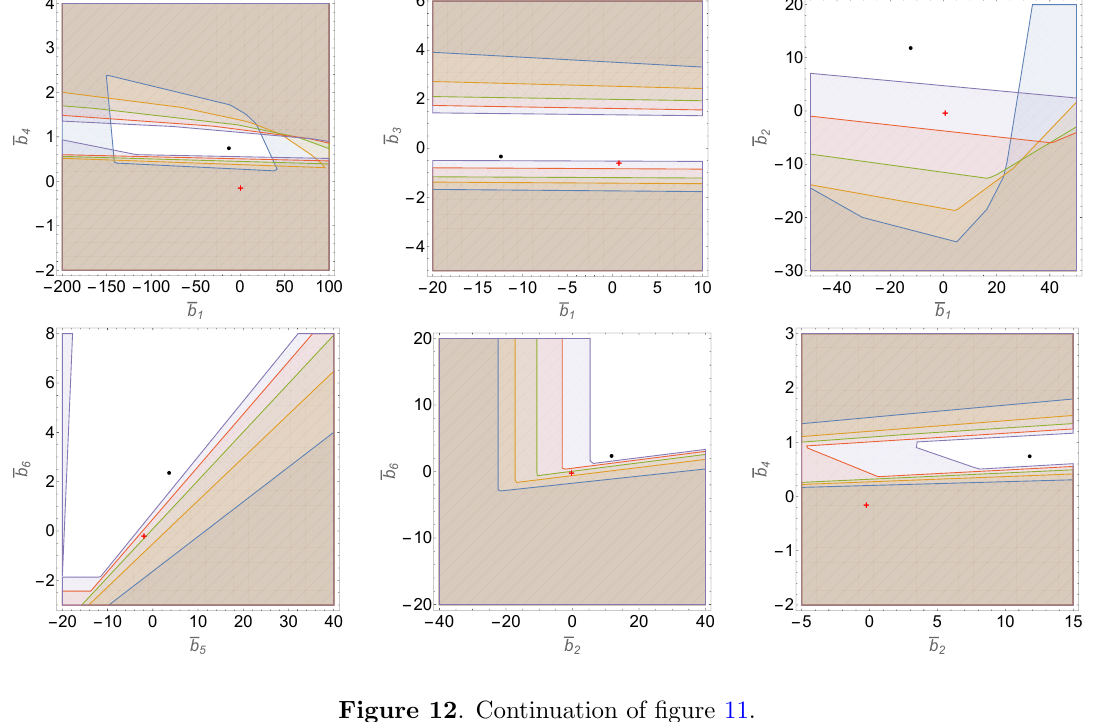
Figure 12 . Continuation of (cid:12)gure 11.